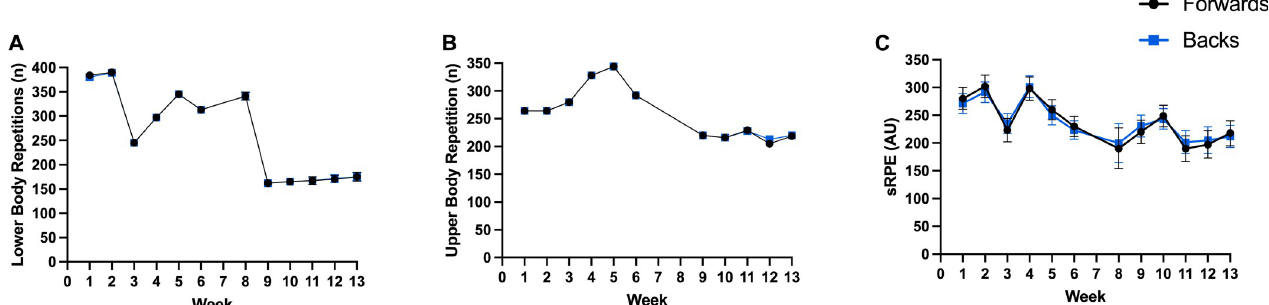
Fig 4. Mean sessional gym-based training load, between positional groups, across weeks. (A) Lower body repetition volume, (B) Upper body repetition volume, (C) Session rating of percieved exertion.